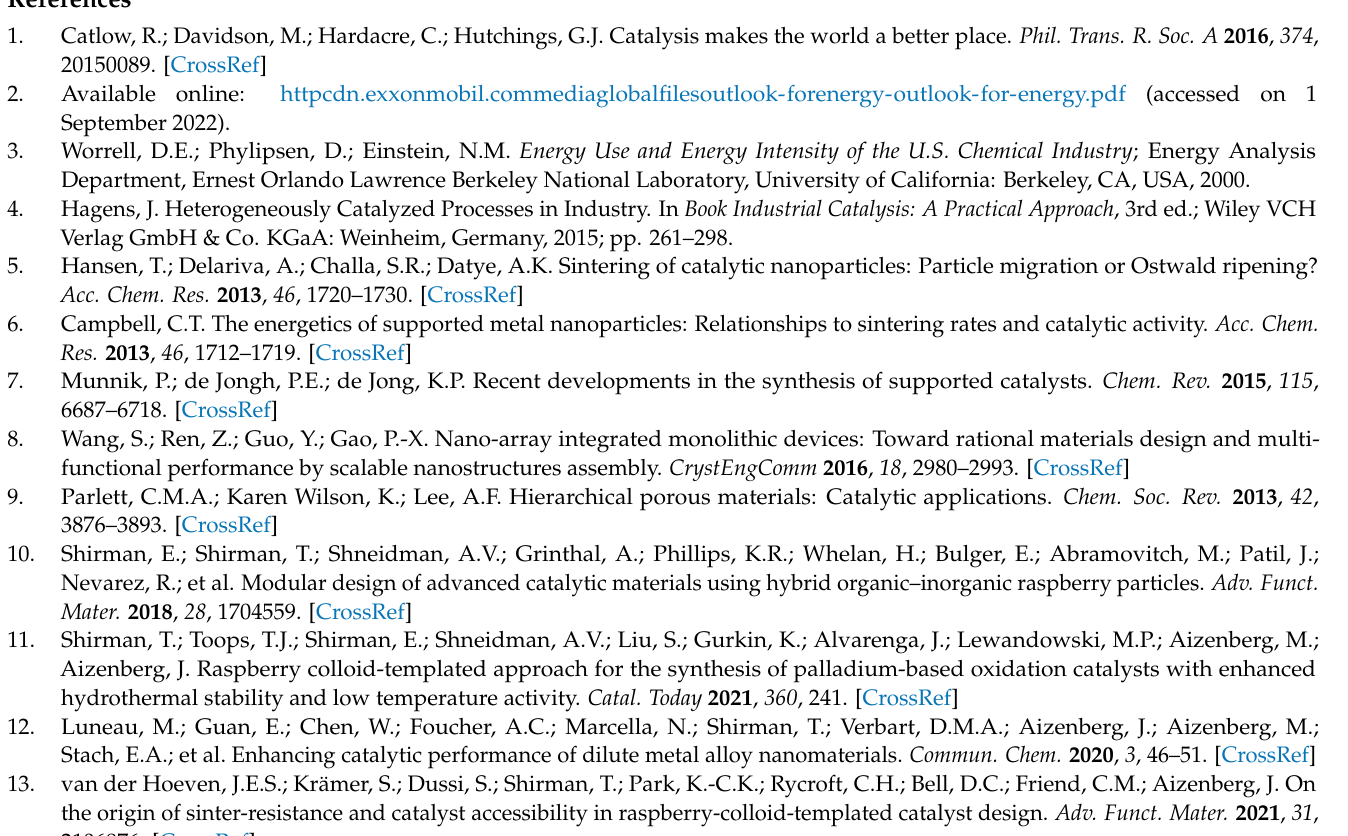
Figure A3. XPS spectra of RCT 1.6Pt/Al 2 O 3 powder: ( a ) survey XPS and ( b ) Pt 4d XPS spectra.